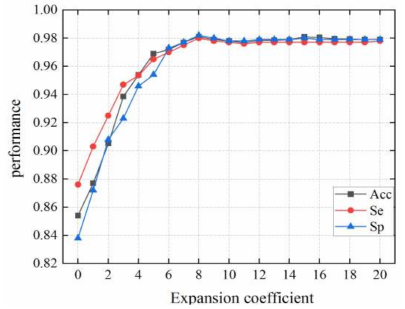
Figure 8. The performance of the CNN model in the DCGAN dataset with different coefficients.